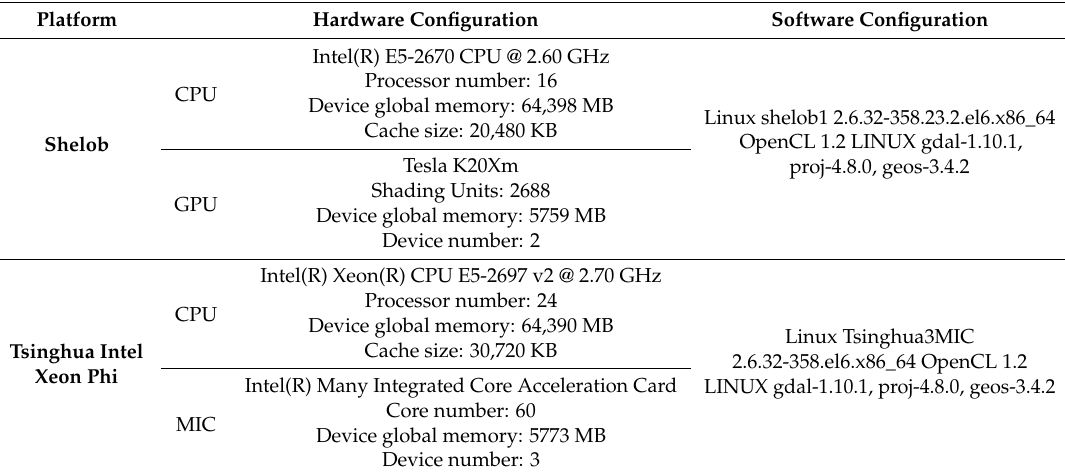
Table 1. Detailed configurations of the experimental